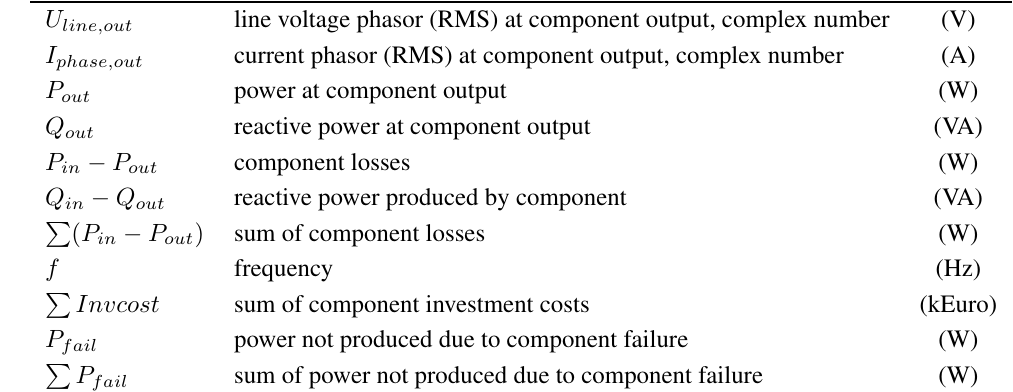
Table 1 . AC bus signals.